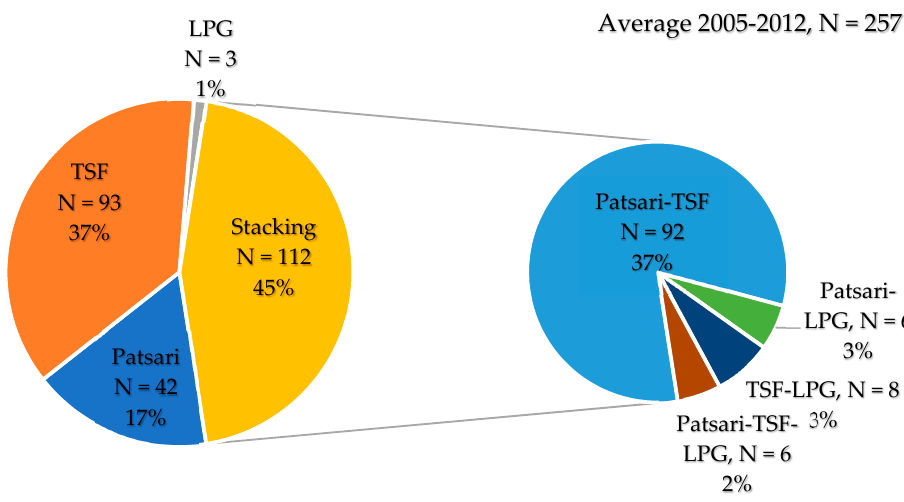
Figure 2. Average patterns of stove and fuels use from the year 2005 to 2012. Source: Field Survey.